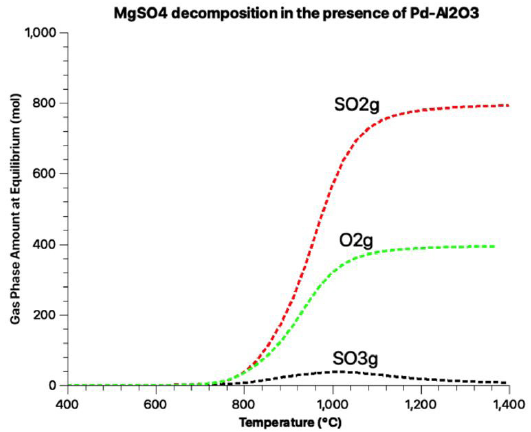
Figure 2. Gas-phase species amount at equilibrium condition as a function of temperature.